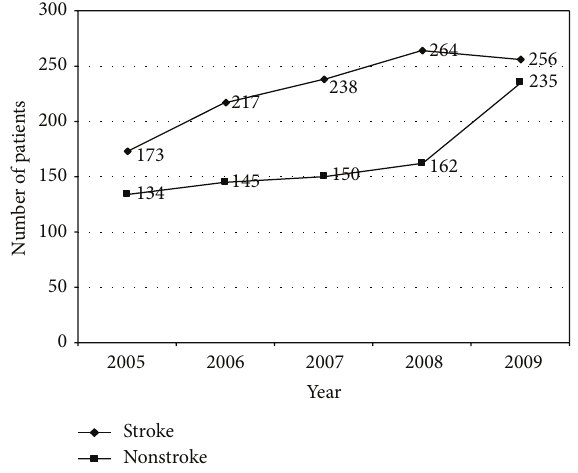
Figure 2: Number of patients admitted to the ASU: comparing stroke patients and nonstroke patients.